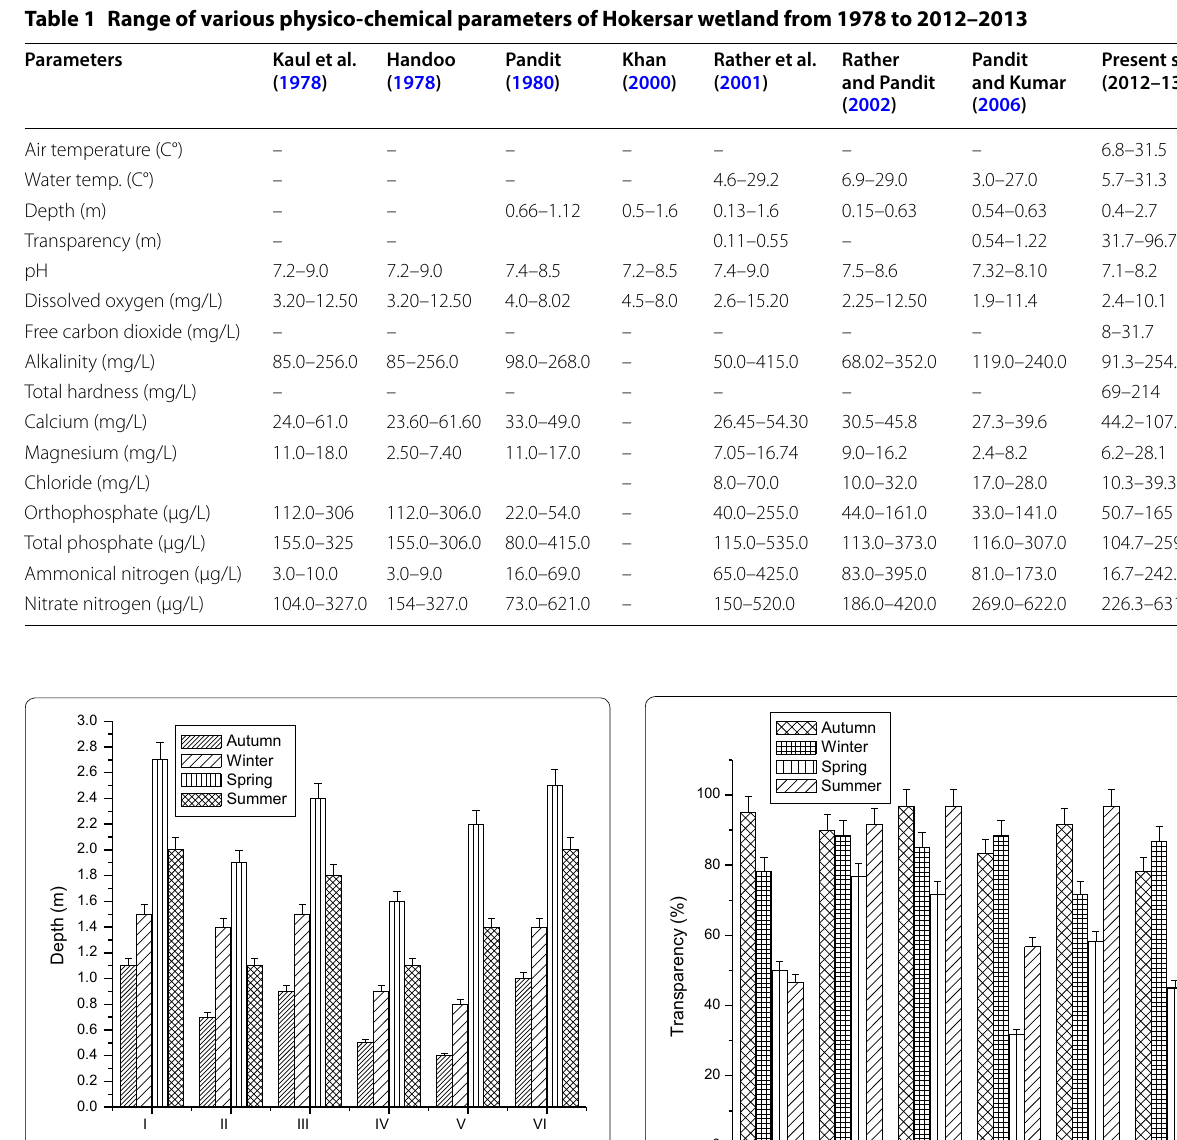
Fig. 4 Spatial and temporal variations of depth (m) in Hokersar wetland during September 2012–August 2013